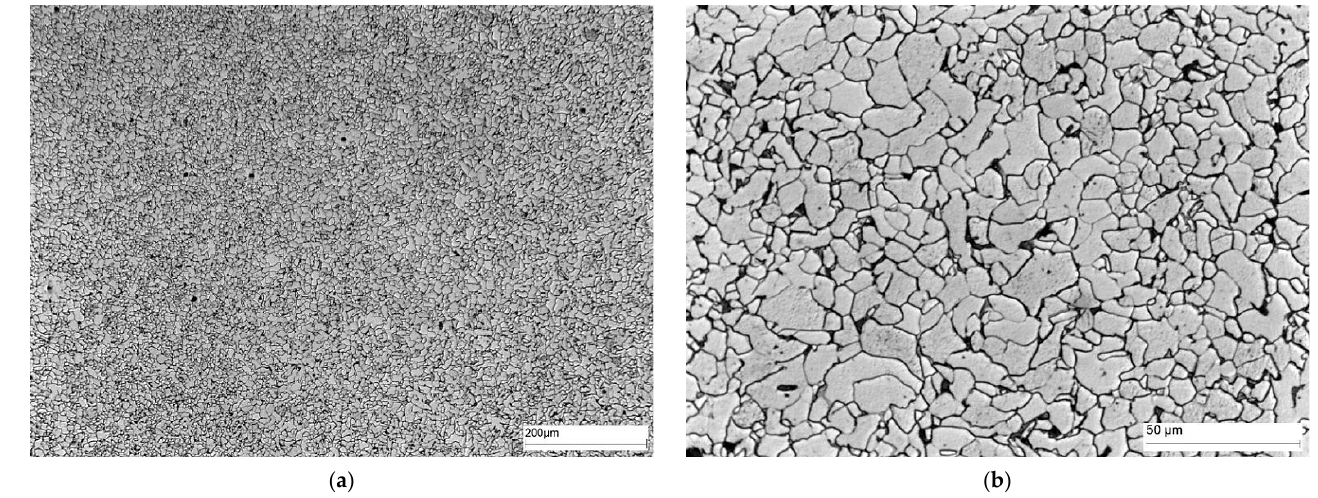
Figure 18. Microstructure of area E of welded joint—SWC: ( a ) magnification 100×, and ( b ) magni- fication 500. Ferrite—white precipitates, and perlite—dark precipitates at grain boundaries.